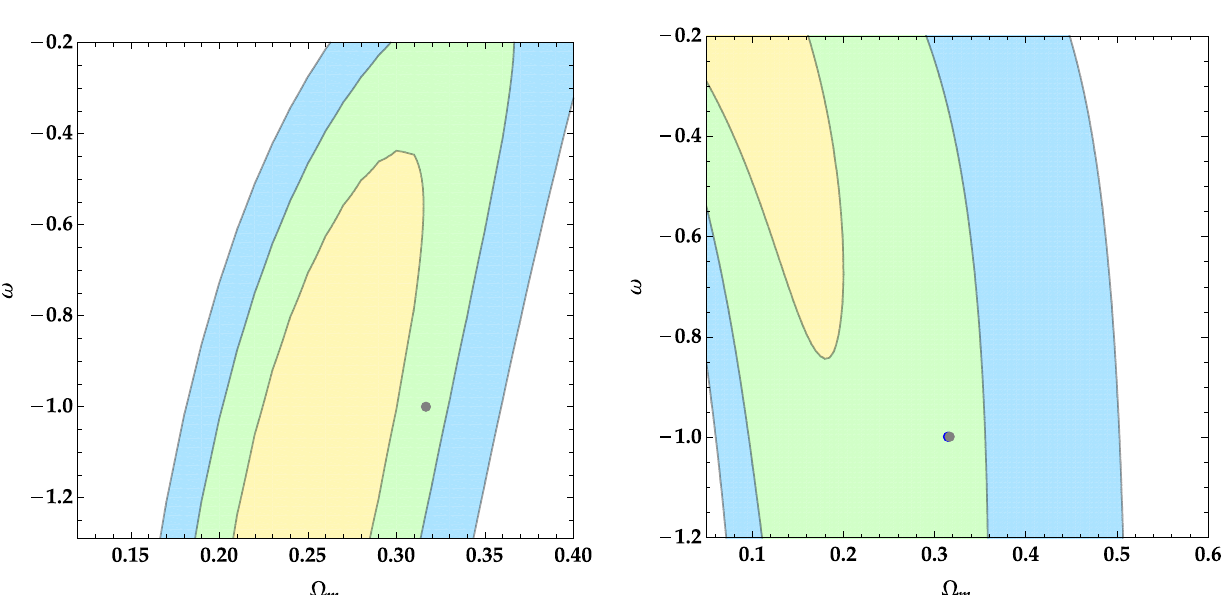
Fig. 2 w vs. Ω m 1 σ , 2 σ and 3 σ confidence regions. Left: maximized contours with σ 8 = 0 . 812. The Planck 2018 point lays at 1 . 56 σ . Right: marginalized contours. The blue point corresponds to Planck 2015 and lays at 1 . 71 σ ; and the grey point corresponds to Planck 2018 and lays also at 1 . 71